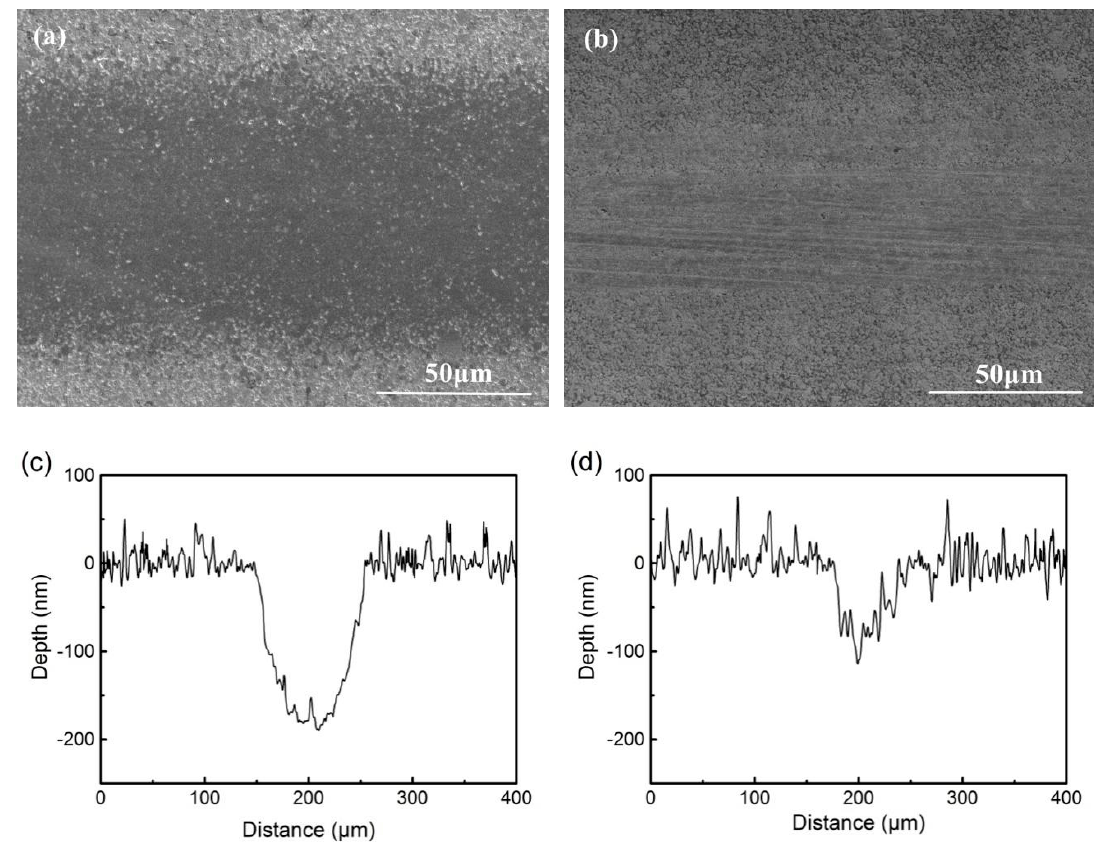
Figure 9. The wear scratch morphology and cross-section of DLC-Si3N4: ( a , c ) Sample 3; ( b , d ) Sample